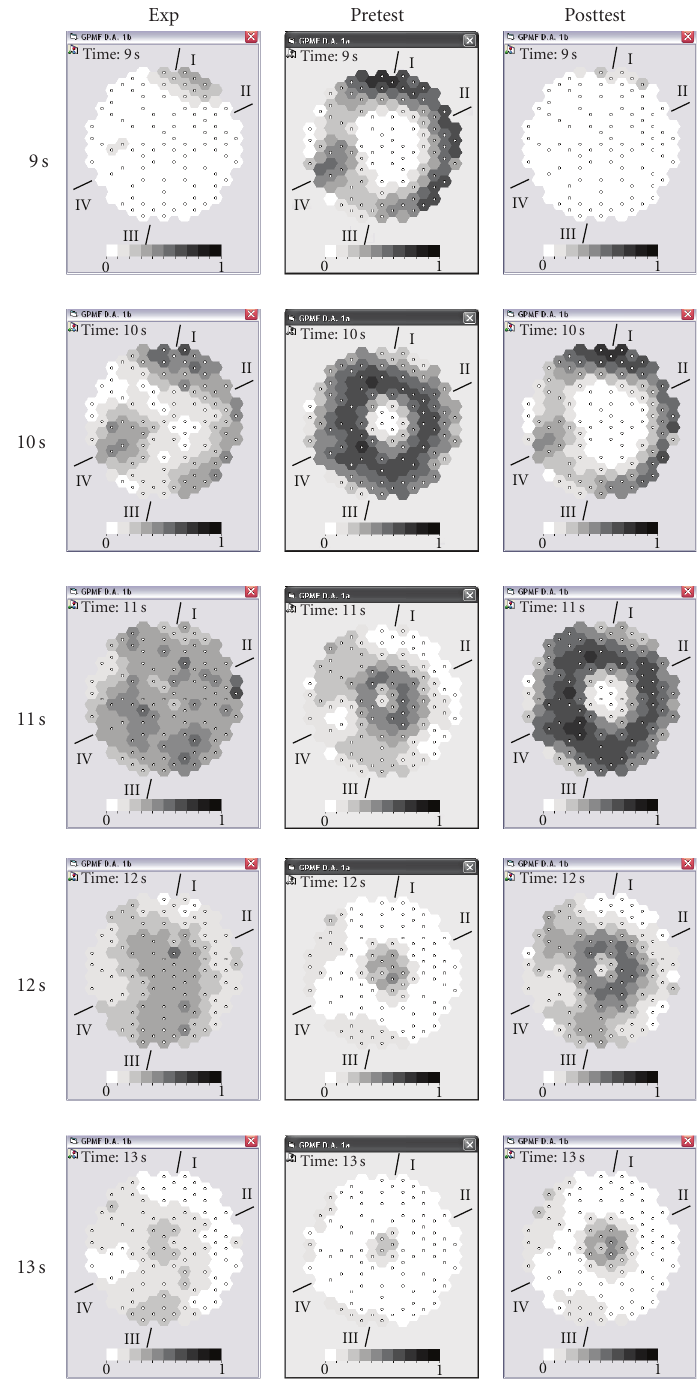
Figure 7: Comparison of mixing scalar distribution at core inlet during slug